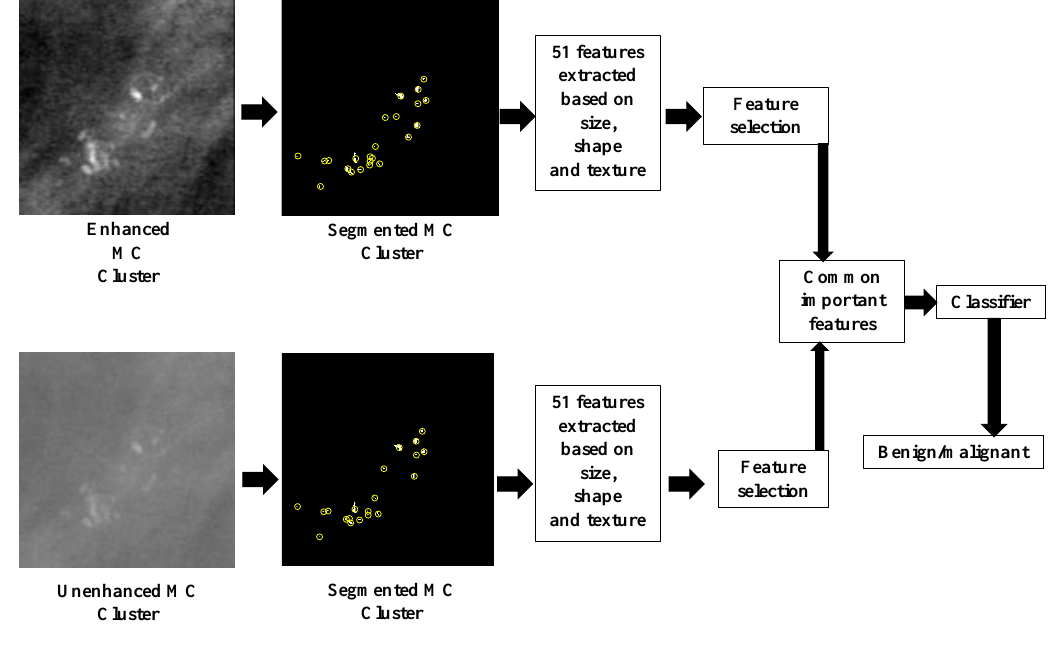
Figure 2. Overview of the proposed MC cluster classification